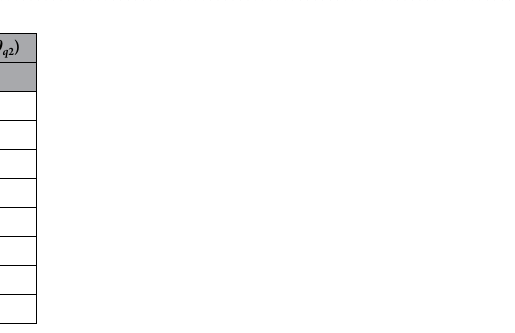
Figure 4. Measured wavelength-tuned transmission spectra at eight waveplate angle sets (Sets I-VIII) in Table 2. A black dashed curve displays the measured zeroth-order comb spectrum for comparison. The inset shows the wavelength shift of λ dip (indicated by a red arrow at Set I), obtained at the eight angle sets. Linear regression resulted in an adjusted R 2 value of ~0.99948.